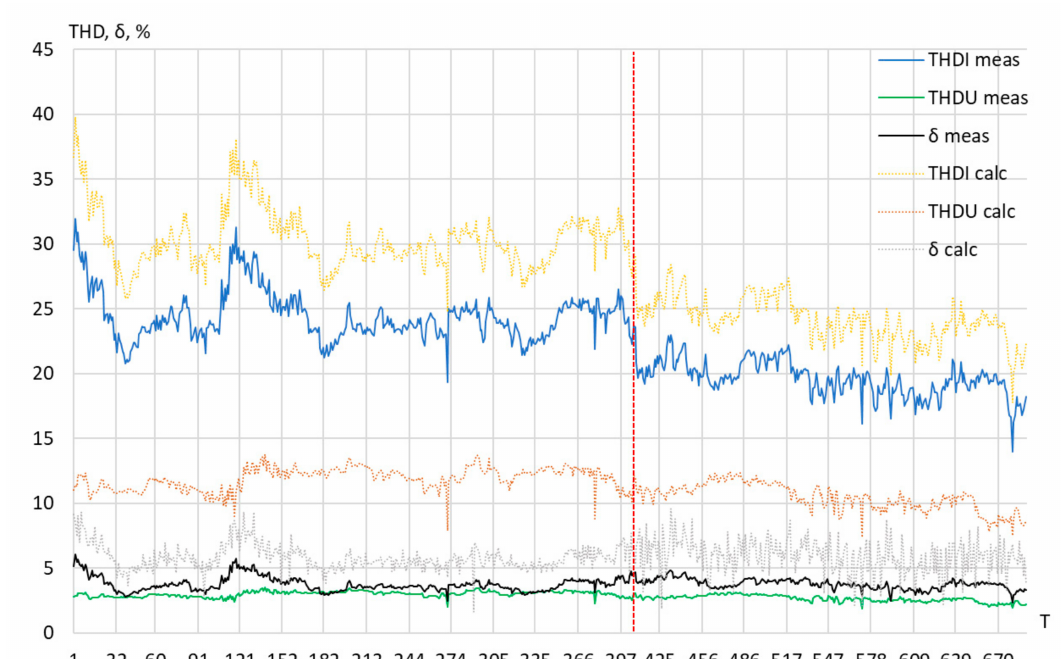
Figure 7. The diagram of the total harmonic distortion—THDU and THDI—and computational error of reactive power measurements according to various